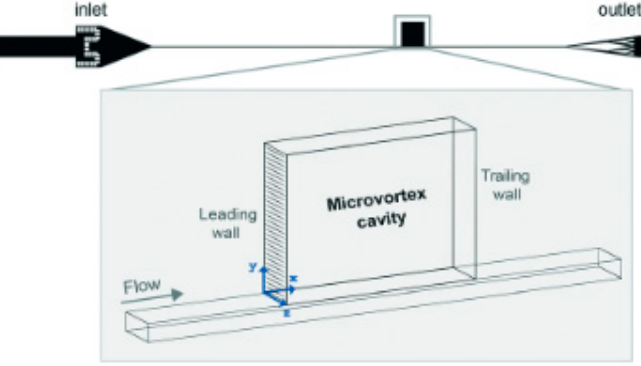
Figure 20. Schematic diagram of the device proposed by Khojah et al. with a micro-cavity 1 cm from the inlet. The microvortex forms in the cavity at high Reynolds number. Reproduced from [103] with permission of The Royal Society of Chemistry.